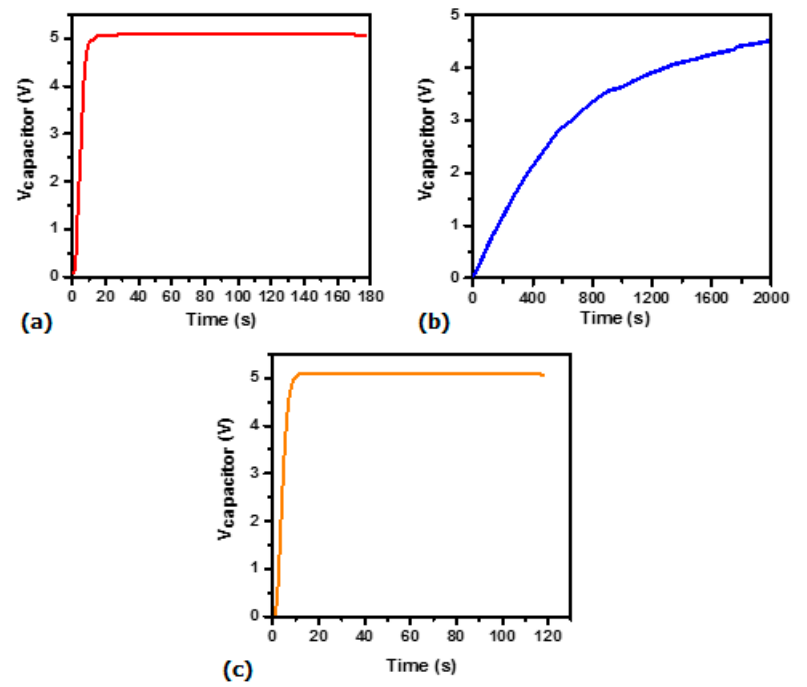
Figure 8. Charging of the capacitor by ( a ) PV films ( b ) piezoelectric films ( c ) combined (TSHG).